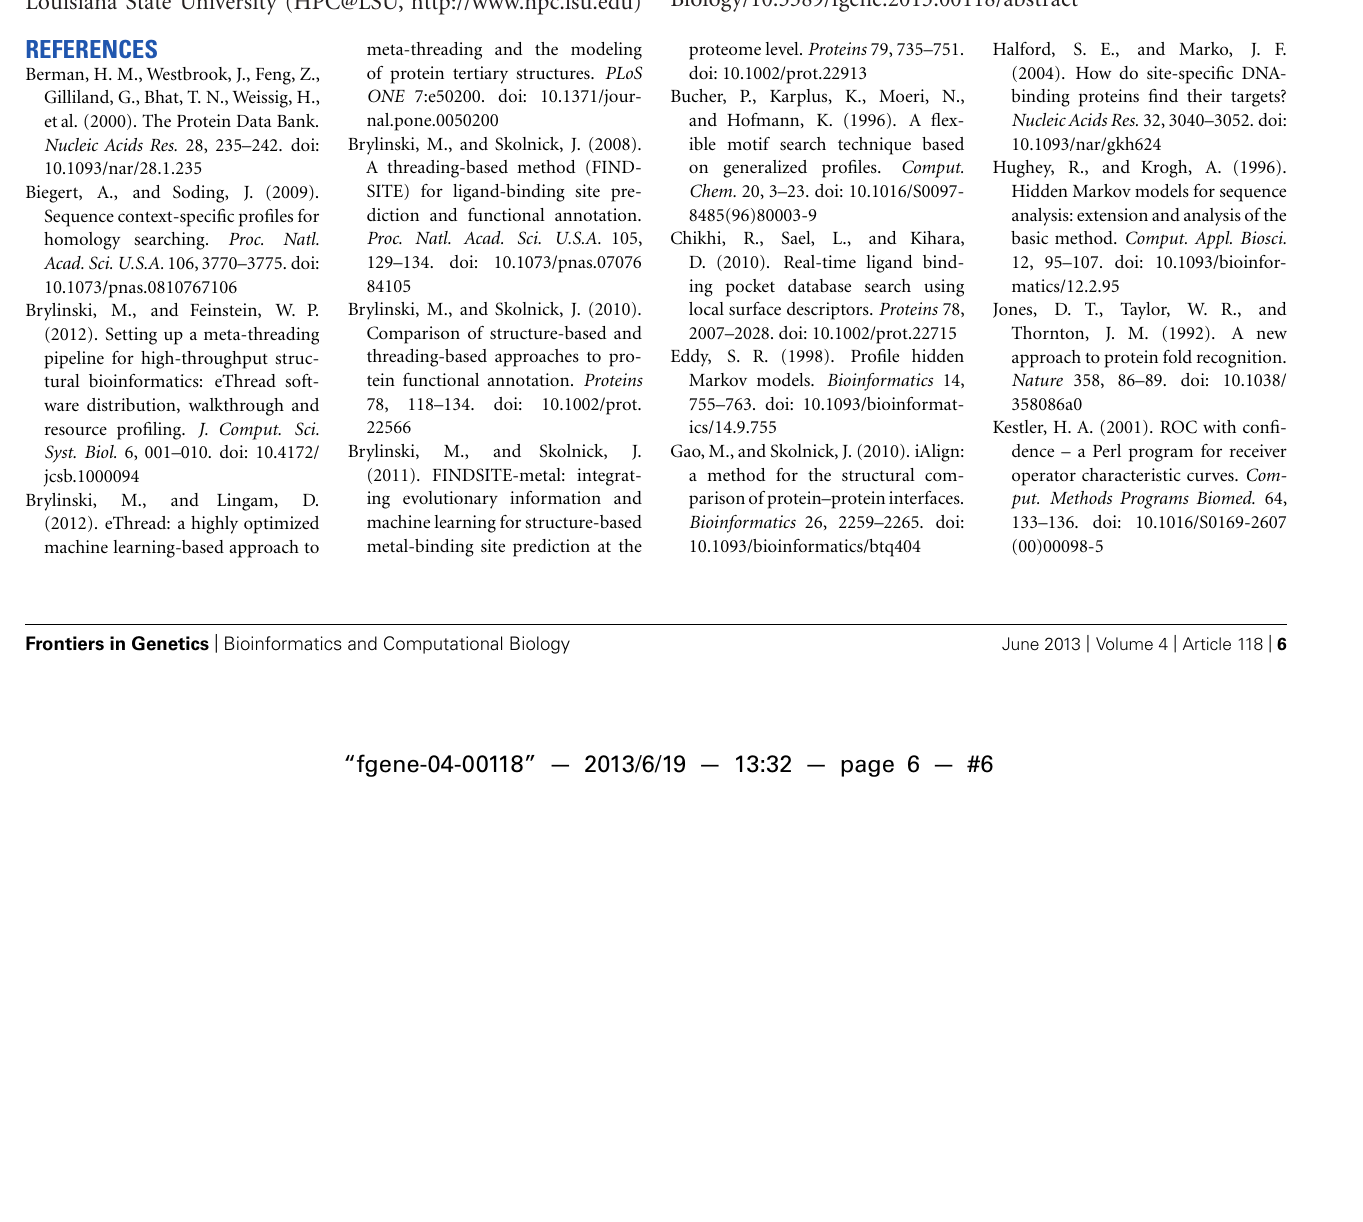
FIGURE 2 | Examples of binding sites in weakly homologous templates. Functional templates are identified by e Thread for (A) aa:CP, (B) NDH-1, (C) PU.1, (D) tnpA, and (E) rAAL.Target structures and bound molecular